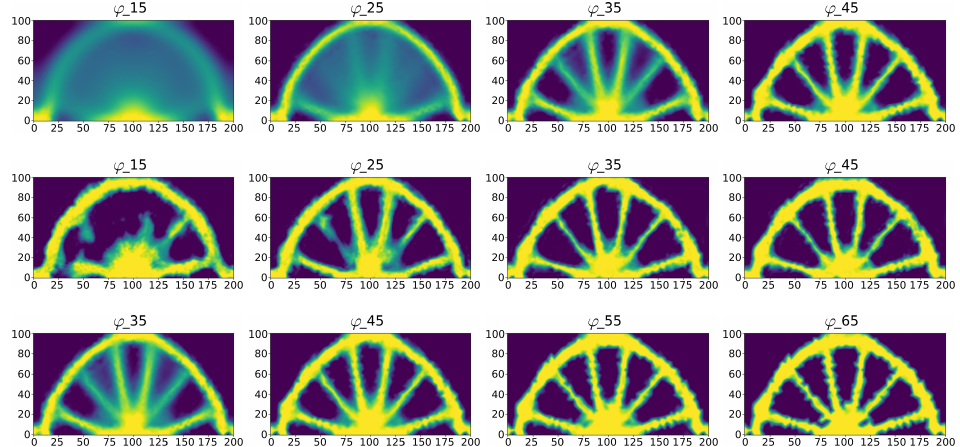
( ϕ n ) ( center row ) in comparison with ϕ LSTM